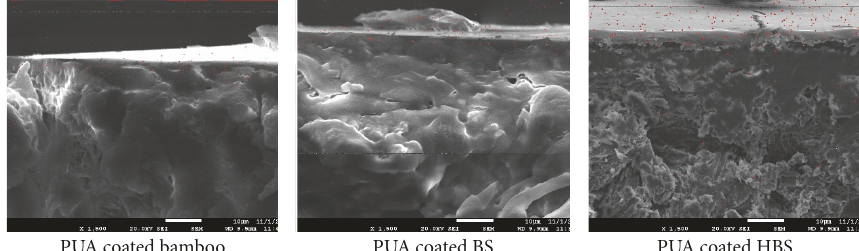
Figure 2: N-element distributions in PUA coated samples.